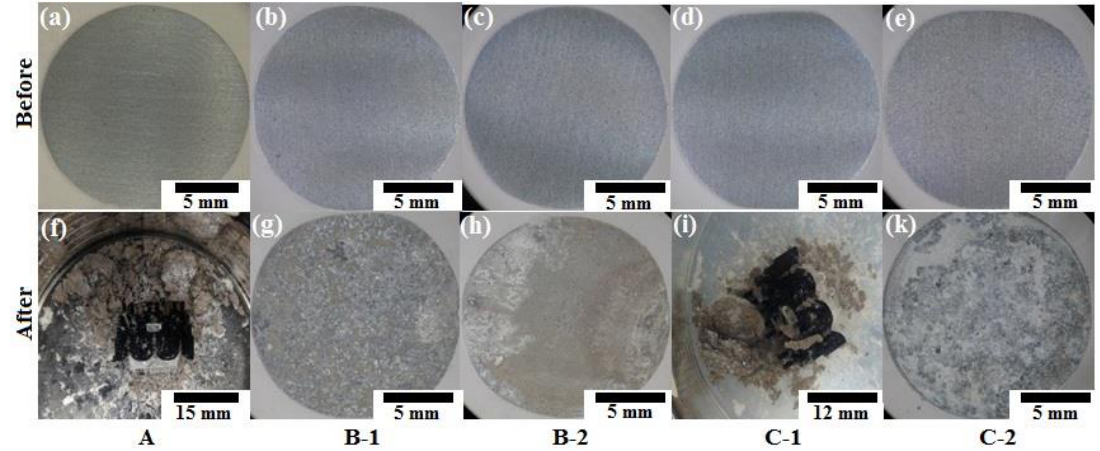
Figure 5. ( a – k ) Surface morphology of samples before and after immersion test.